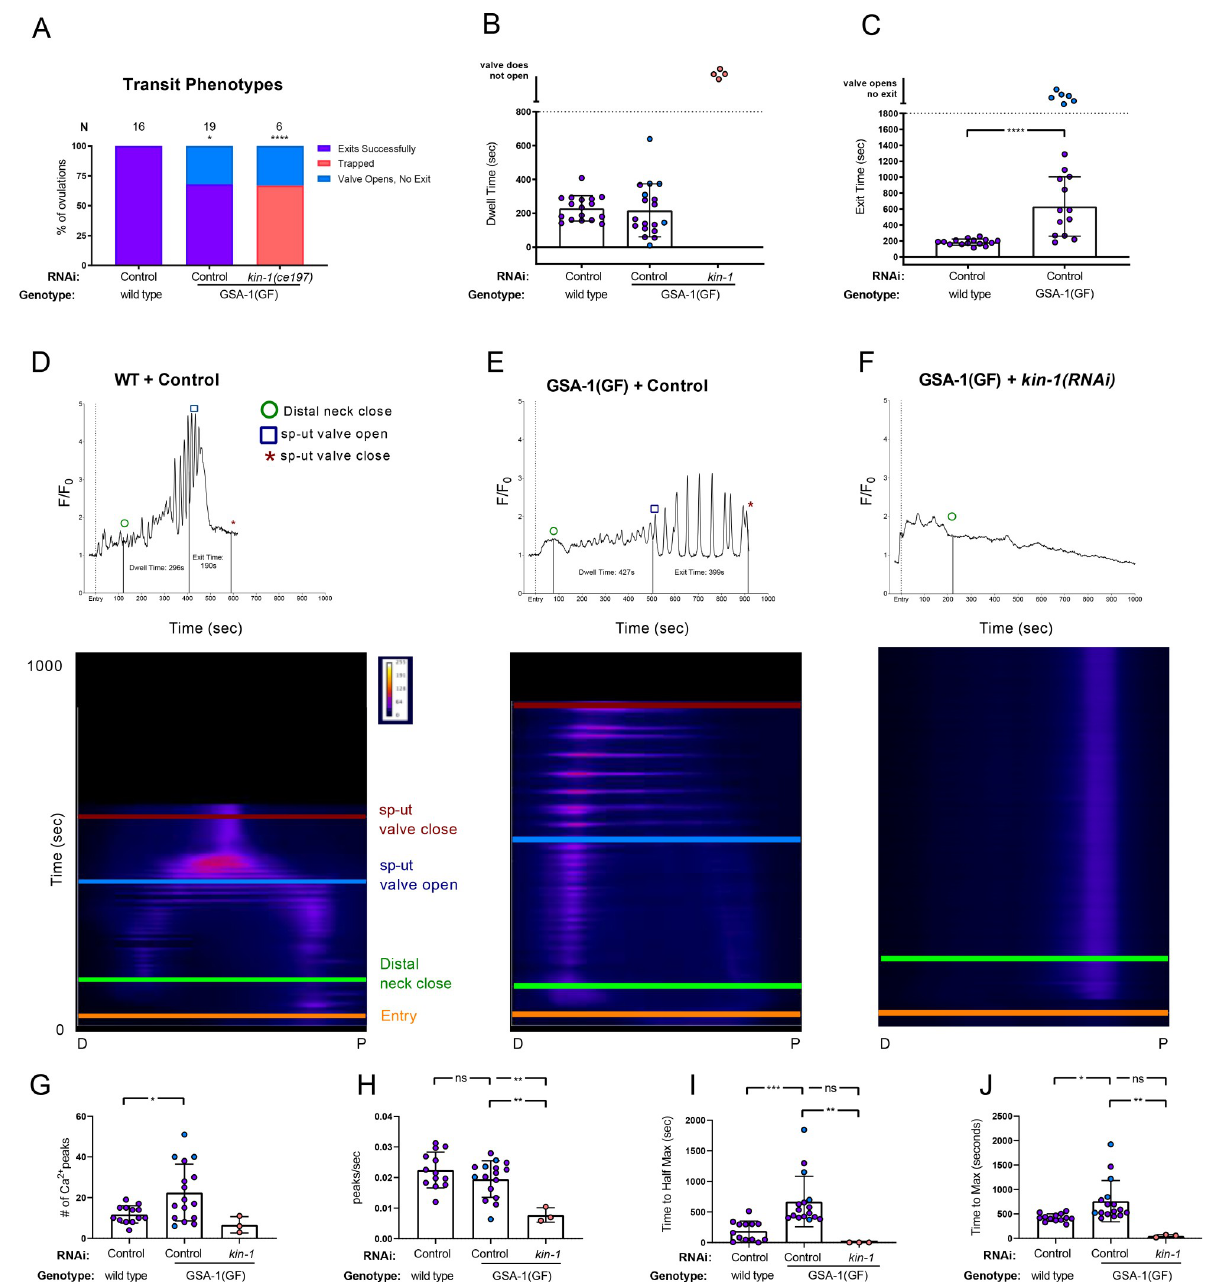
Fig 2. GSA-1(GF) induction of Ca 2+ signaling in the spermatheca is dependent on KIN-1/PKA-C. (A) Transit phenotypes of the ovulations of wild type animals treated with control RNAi, and GSA-1(GF) animals treated with control RNAi and kin-1(RNAi) ,were scored for successful embryo transits through the spermatheca (exits successfully), failure to exit (trapped), reflux into the gonad arm (returns to gonad arm), and the situation in which the sp- ut valve opens, but the embryo does not exit (valve opens, no exit). The total numberof oocytes that exited the spermatheca successfully was compared to the sum of all other phenotypes using the Fisher’s exact t -test.Control RNAi was compared to all other RNAi treatments. Dwell (B) and exit (C) times of movies in A were analyzed using Fishers exact t -test(two dimensional x 2 analysis). Color coding of the data points corresponds to the transit phenotypes in A. Representative normalized Ca 2+ traces and kymograms of movies in A (D-F) are shown with time of entry, distal neck closure, and time the sp-ut valve opens and closes indicated. Levels of Ca 2+ signal were normalized to 30 frames before oocyte entry. Kymograms generated by averaging over the columns of each movie frame (see methods).Refer to S3A Fig and S5A and S5B Fig for additional Ca 2+ traces, and S4A Fig and S6A and S6B Fig for additional kymograms. (G-J) Color coding of the data points corresponds to the transit phenotypes in A. (G) The number of Ca 2+ peaks, (H) the peaks per second, and the amount of time after oocyte entry required to reach either (I) half the maximum or (J) maximum Ca 2+ signal were quantified for wild type animals treated with control RNAi, and GSA-1(GF) animals treated with control RNAi and kin-1(RNAi) .These were compared using one-way ANOVA with a multiple comparison Tukey’s test. Stars designate statistical significance ( ��� p < 0.005, �� p < 0.01, � p < 0.05).